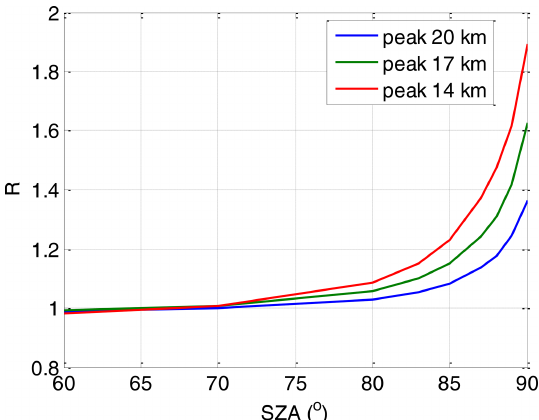
Figure A1. Scaling factors R accounting for the BrO SCD differ- ences at different wavelengths as a function of the SZA. For the BrO correction in the OClO retrieval, the factors modelled for a BrO pro- file with a peak at 17km are used. Plotted also are values for two additional BrO profile peak